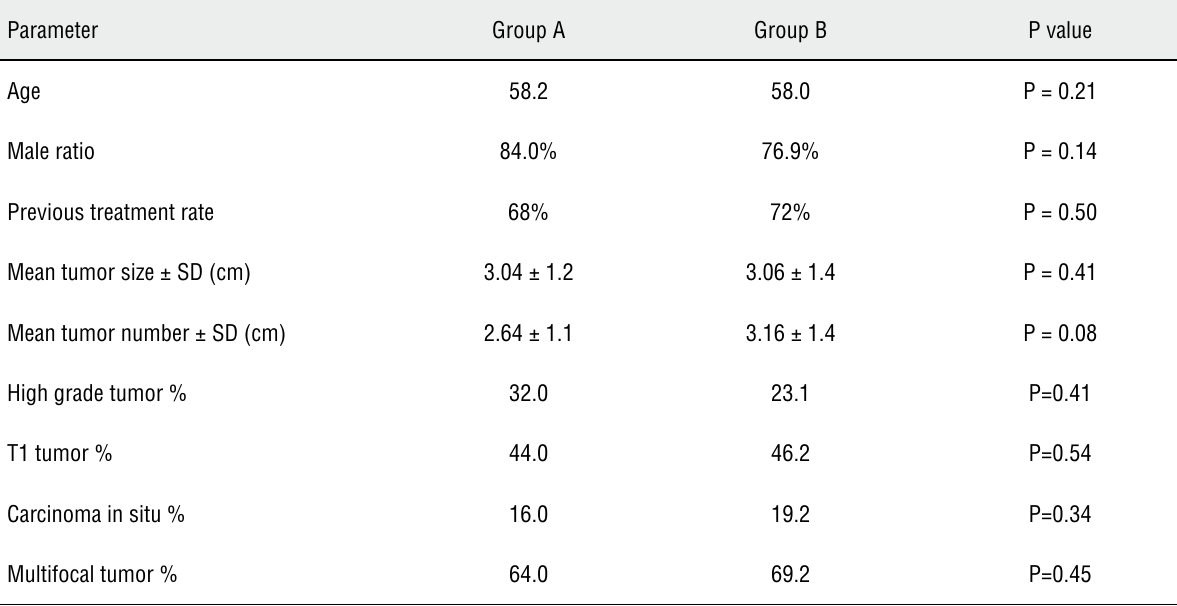
Table-1. The percentage of patients with high table 1 - clinical data concerning the demographic characteristics and tumor releated